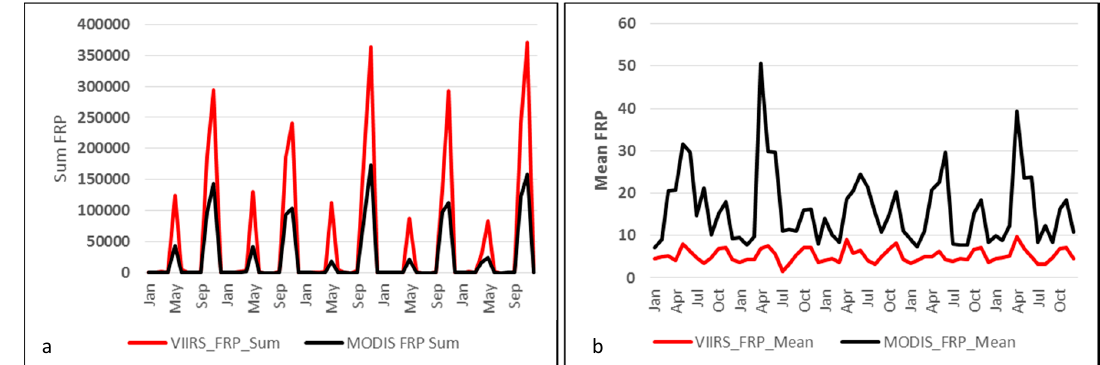
Figure 5. Seasonal variations in monthly sum of fire radiative power (FRP) ( a ) and mean FRP ( b ) for Punjab, India derived from MODIS (Aqua) and VIIRS data. Note that the mean MODIS Aqua FRP is higher than the VIIRS FRP, whereas the sum of FRP is higher for VIIRS than MODIS due to the relatively large number of fires detected by VIIRS.